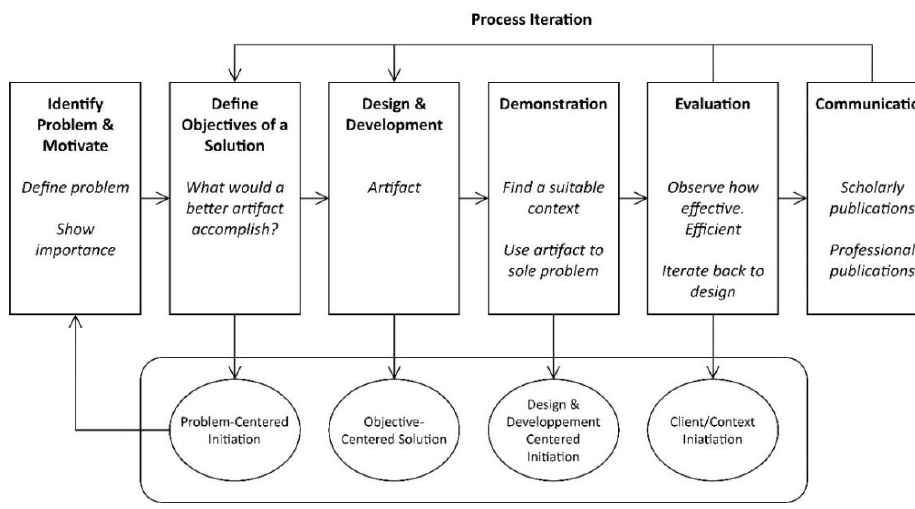
Figure 1. This scheme shows the different steps of the DSR, as presented in (Lawrence et al., 2010)